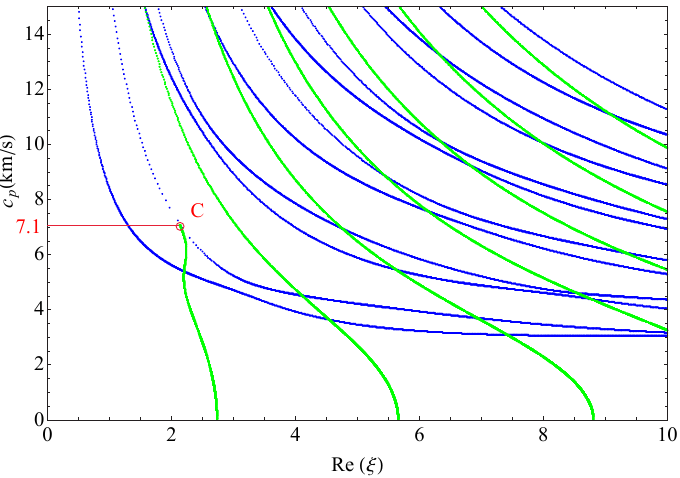
Figure 17. Phase velocity spectra ( n = 1).